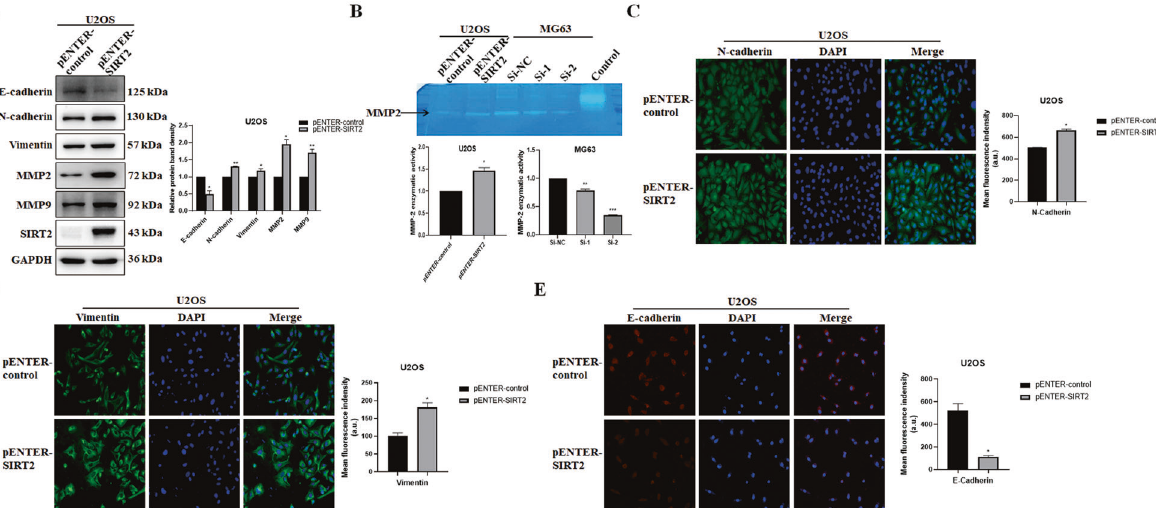
Fig. 4 SIRT2 overexpression downregulates the epithelial marker and upregulates mesenchymal proteins. A The expression of EMT- related proteins was detected by Western blot after SIRT2 overexpression in U2OS cells. Results from three experiments are summarized in a histogram format. B The gelatin zymogram assay was used to detect the activity of MMPs with SIRT2 overexpression or knockdown. Data from a representative experiment of three independent samples are shown. C – E Representative immuno fl uorescence of N-cadherin, Vimentin and E-cadherin with SIRT2 overexpression was shown. The right panel was the summarized data of immuno fl uorescence score of related protein. (* P < 0.05, ** P < 0.01, *** P <